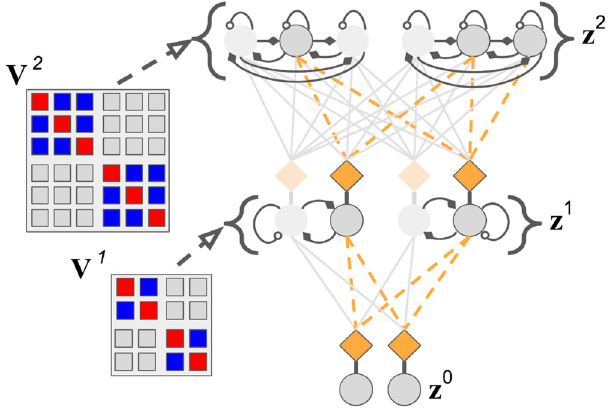
Fig. 3 Lateral dynamics of generative neural coding. Depending on how the lateral connectivity matrices, V 1 and V 2 , are designed, different competition patterns emerge among neurons in the network. In the system with lateral matrices (shown below), each neuron is driven by its own self- excitation (red-colored blocks) and laterally inhibits (blue-colored blocks) other neurons that inhabit the same group (of 2 or 3 units). In the fi gure, one possible outcome (or agent state) of such a competition is shown (at the end of a T -step stimulus presentation window). Self-excitation and lateral inhibition strengths are controlled by coef fi cients set a priori. Dashed orange edges show actively used synapses, fi lled diamonds indicate inhibitory signals, and non- fi lled circles indicate excitatory